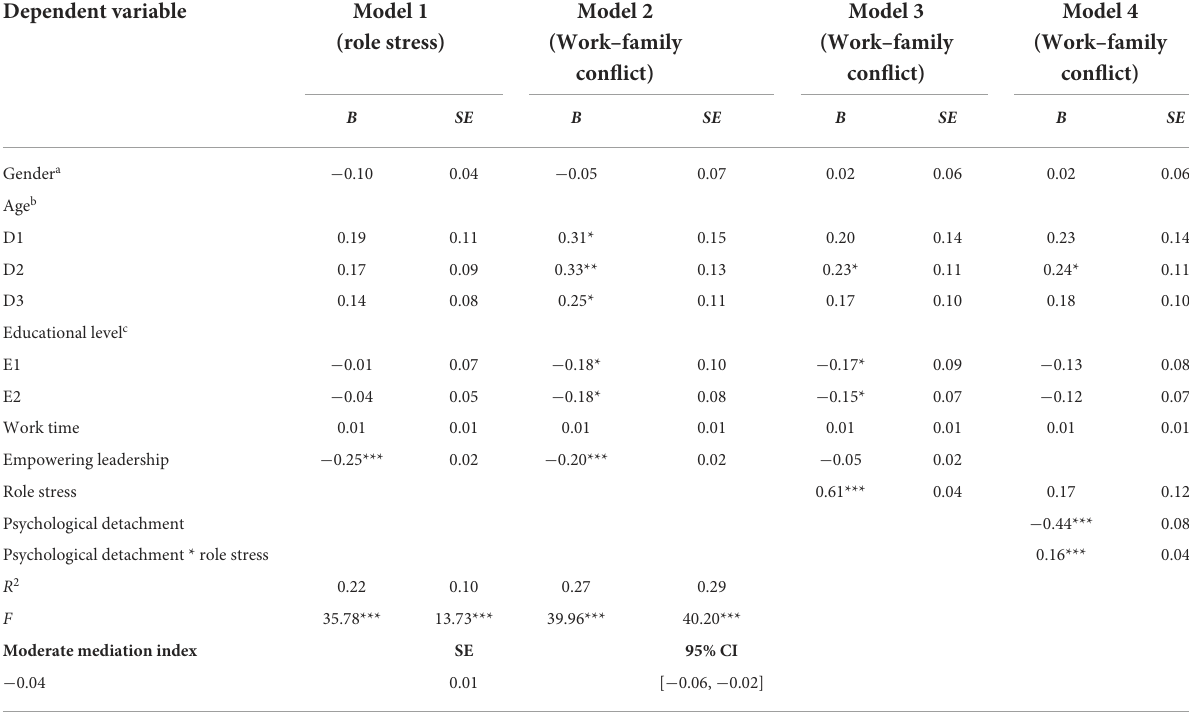
TABLE 3 Mediating effect of role stress on the relationship between empowering leadership and work–family conflict.